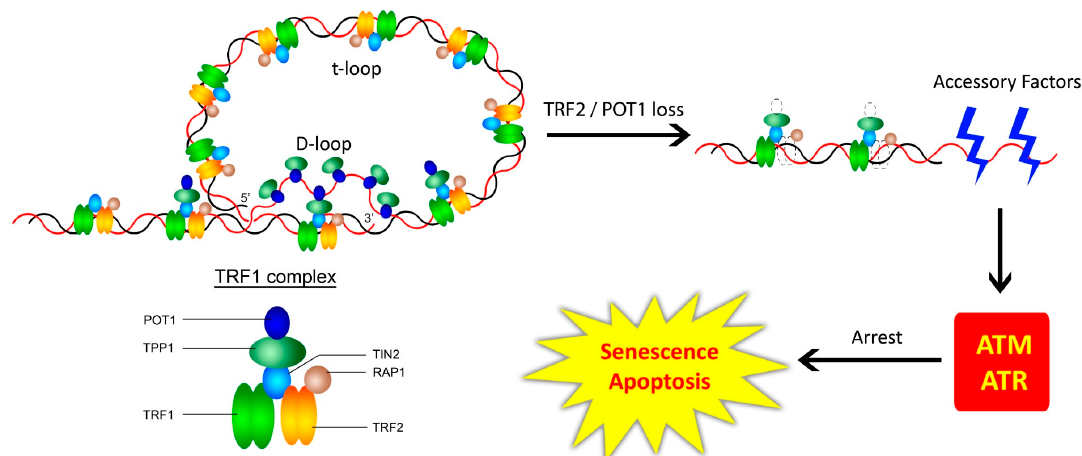
Figure 1. Shelterin—The Border Security Force. The longstanding basic model posits that the six protein-complex directly associated with telomeres facilitates loop formation and protects it from illegitimate access by various factors, regulates access by the legitimate ones, and aids telomere replication. ‘t-loop’ stands for telomeric loop, while ‘D-loop’ stands for displacement loop. In mammalian cells, loss of shelterin proteins can lead to DDR, TRF2, and POT1 directly serving to inhibit ATM and ATR kinases, respectively, and a loss of TRF2 or POT1 would de-repress the association of ATM/ATR to the telomeres, resulting in senescence or apoptosis. Adapted from